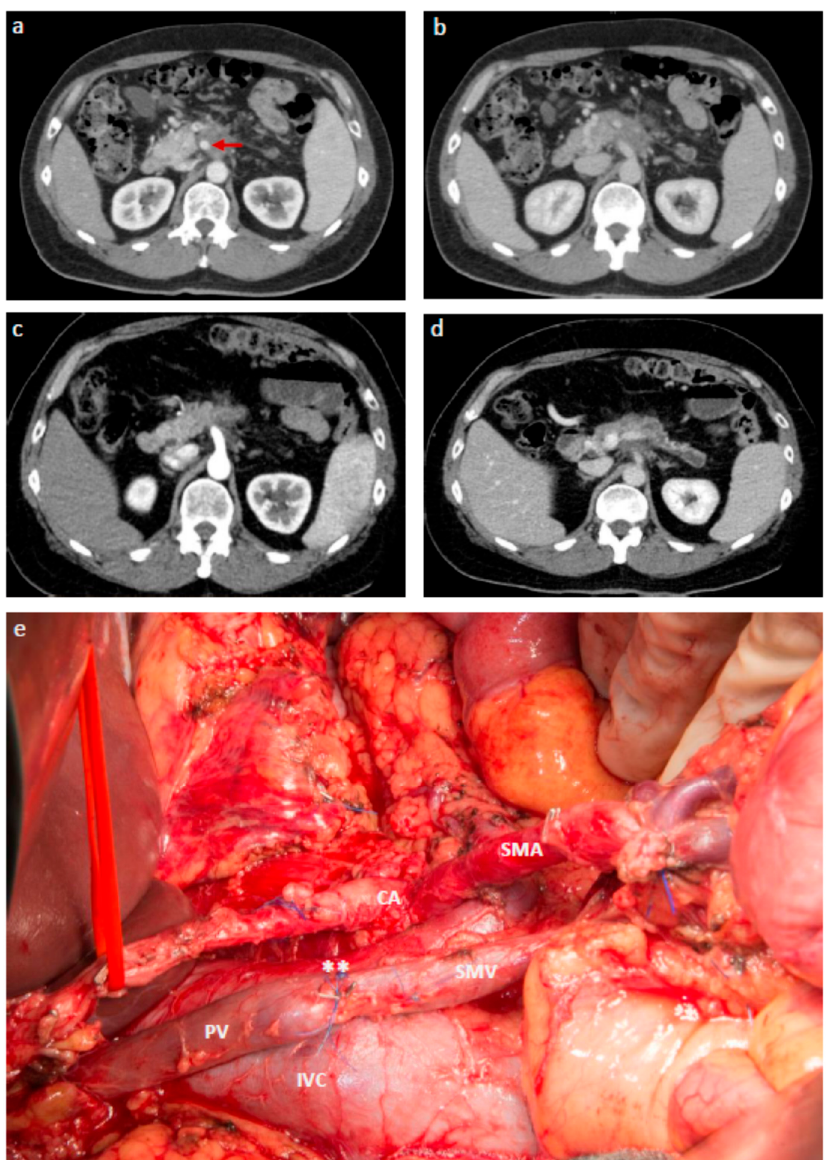
Figure 1. LAPC with partial response after NAT receiving extended tumor resection with perivascular dissection: a–d: Transverse multidetector contrast enhanced CT images taken before initiation of NAT (( a ) arterial phase; ( b ), venous phase) and after completion of NAT with three cycles of FOLFIRINOX and 11 cycles of FOLFIRI ( c , arterial phase; d , venous phase). Unresectable PDAC of the pancreatic body with encasement of the SMA (red arrow in a) and cavernous transformation of the portal vein ( b ). Partial response on CT ( c and d ). ( e ): Operative site after extended tumor resection with artery first, total pancreatectomy, splenectomy, adrenalectomy, subtotal gastrectomy, subtotal colectomy, TRIANGLE-operation with PV/SMV resection (**) and perivascular level-III dissection around the SMA and celiac axis (CA). Final pathology showed ypT2, ypN1 (1/49), L0, V0, R0. The patient had a peritoneal recurrence at 24 months after resection.